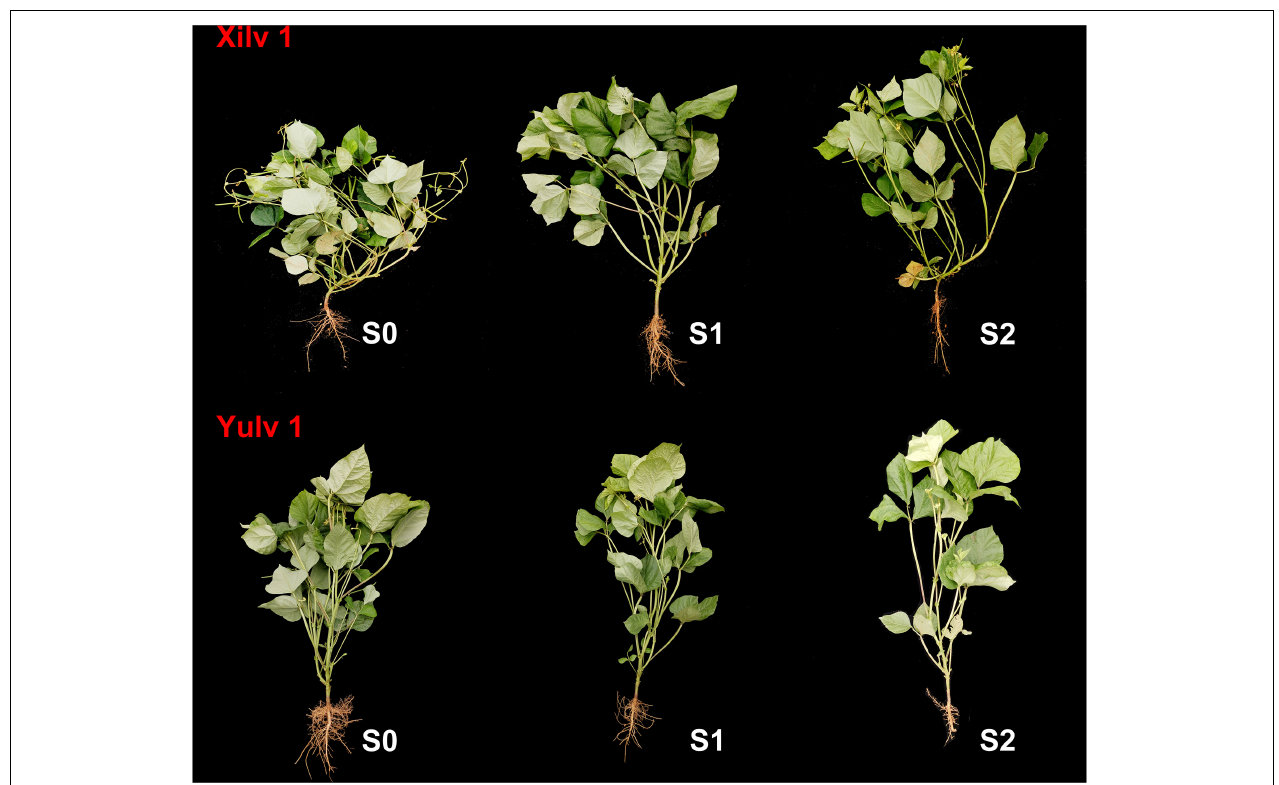
FIGURE 3 | Morphological characteristics of mung bean under shading stress. S0, no shading; S1, moderate shading; and S2, severe